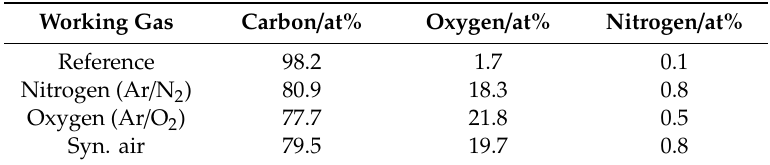
Figure 2. Elemental composition (Nitrogen, Oxygen and Carbon) of WPC with 60% wood content in PP before and after plasma treatment with 90% argon and 10% nitrogen as working gas. Table 1. Elemental composition of WPC specimens surfaces (X-ray photoelectron spectroscopy (XPS) measurement) with 60% wood content in PP before and after plasma treatment with different working gases.